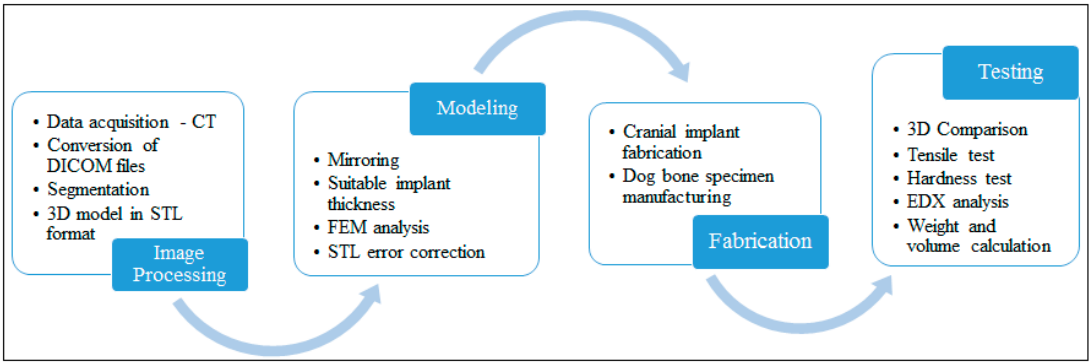
Figure 1. Methodology to obtain a customized cranial implant.